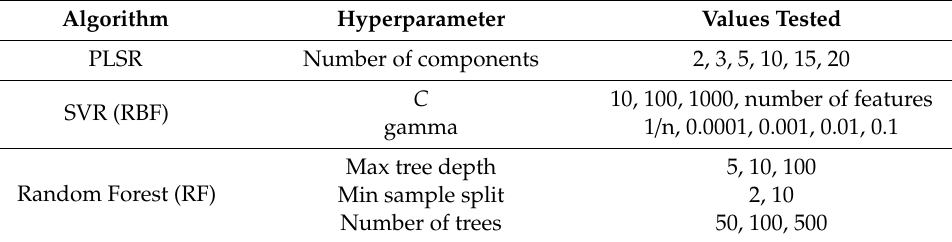
Table A6. Grid search parameters for regression methods.